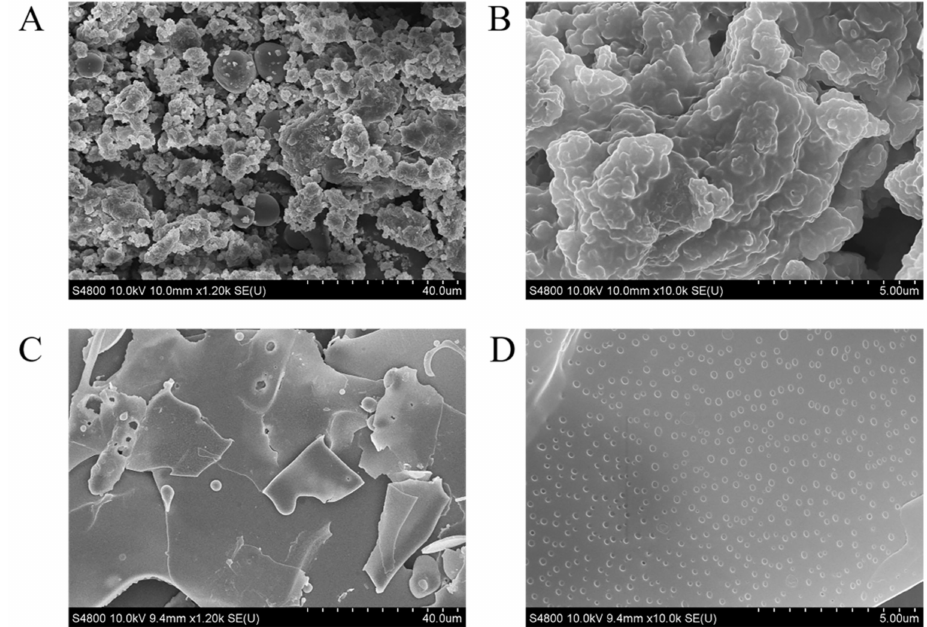
Figure 2. SEM image of TSCP ( A , B ) and TSCPN ( C , D ). The magnifications of ( A , C and B , D ) are 1200 and 10,000 times,